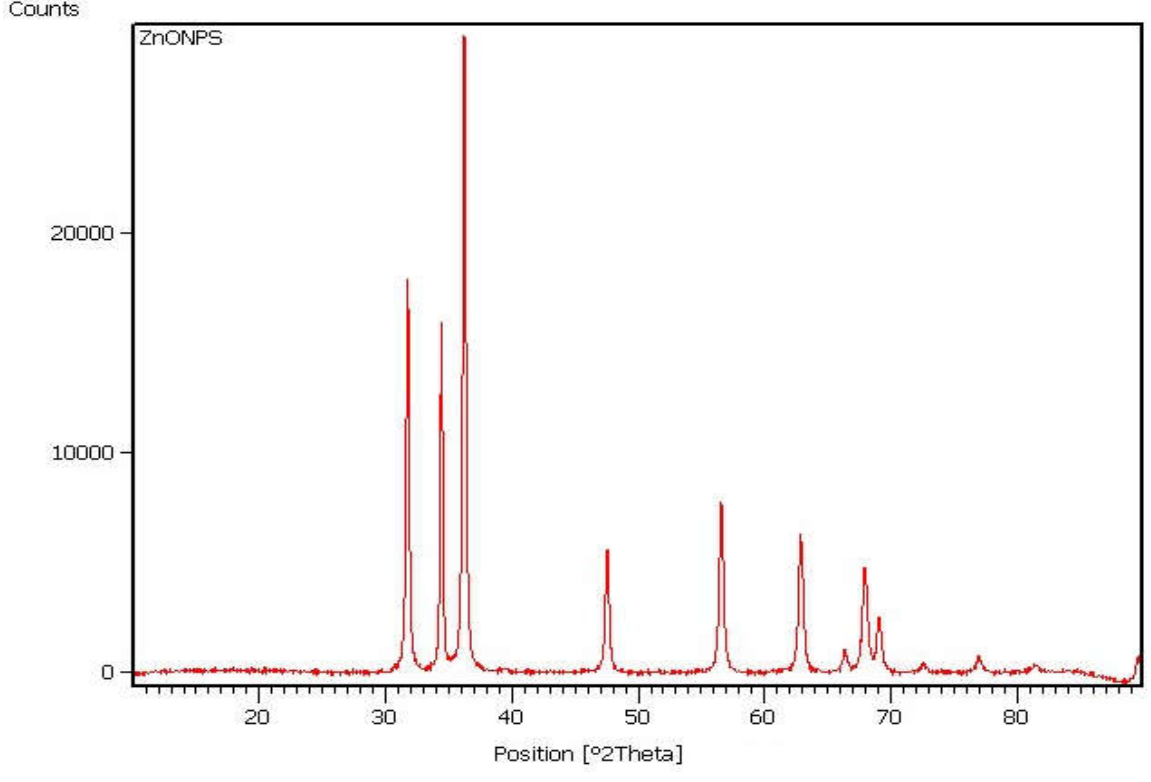
Figure 2. XRD pattern of ZnO NPs.